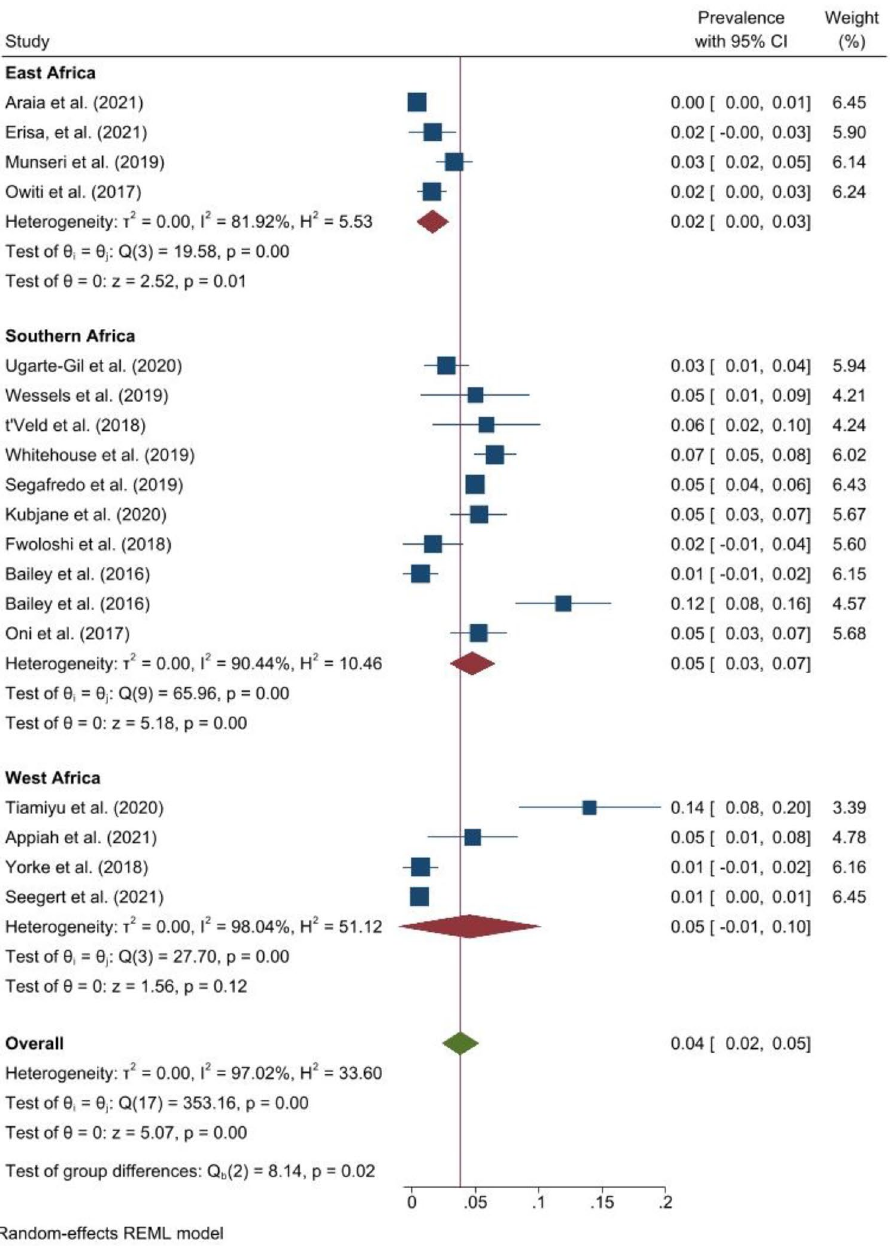
Figure 6. Forest plot showing prevalence of obesity among people with active TB in